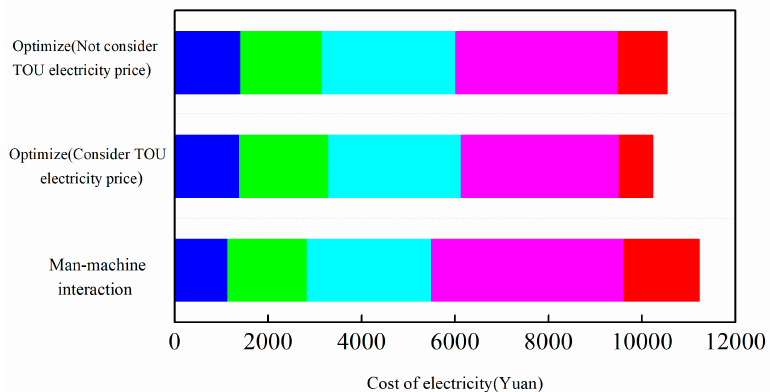
Figure 12. Electricity costs of three rolling plans.